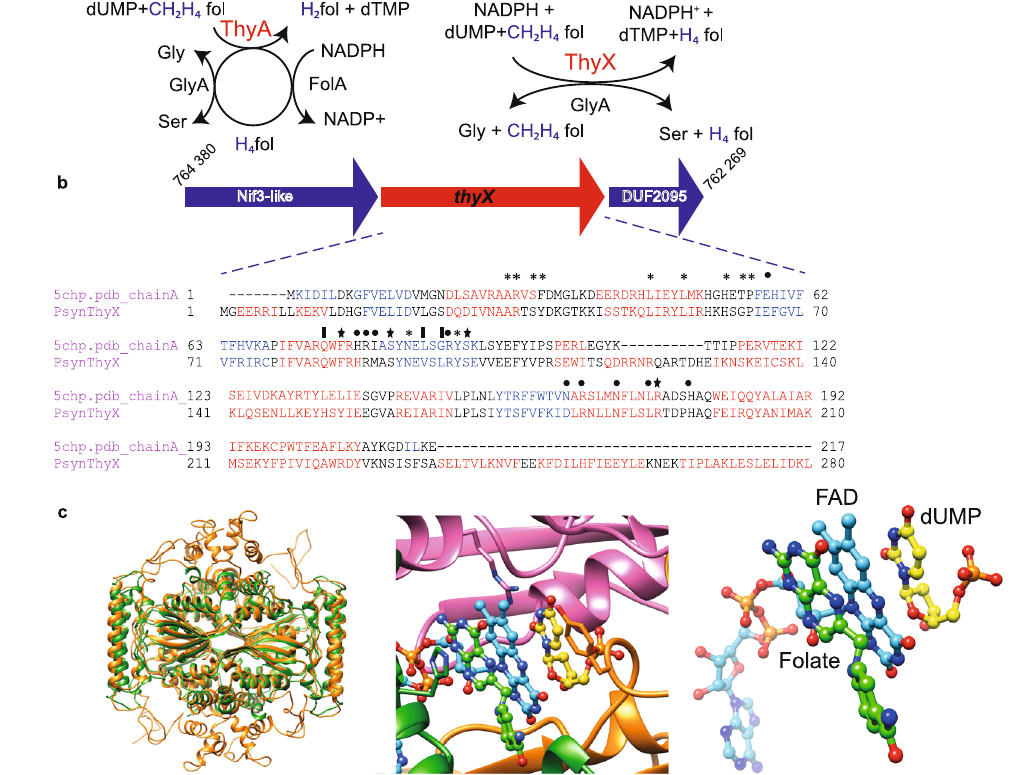
Fig. 1 | ThyA- and ThyX-dependent folate cycles. a ThyA catalyzes the methyla- tion of dUMP to dTMP, leading to the formation of H 2 folate that is subsequently reduced by FolA (left panel). The fl avoenzyme ThyX uses methylene from CH 2 H 4 folate and acquires the reducing hydride from NADPH. CH 2 H 4 folate func- tions only as carbon source, resulting in H 4 folate at the end of the catalytic cycle (right panel). Serine hydroxymethyltransferase GlyA is universally present. b Psyn thyX is located between the nucleotides 765,745 and 764,847 on the genome of Psyn (NZ_CP042905, 4 427 796bp). The Psyn thyX gene is surrounded by the nif3 and DUF2095 genes. For details, see text. Structure-based sequence alignment of